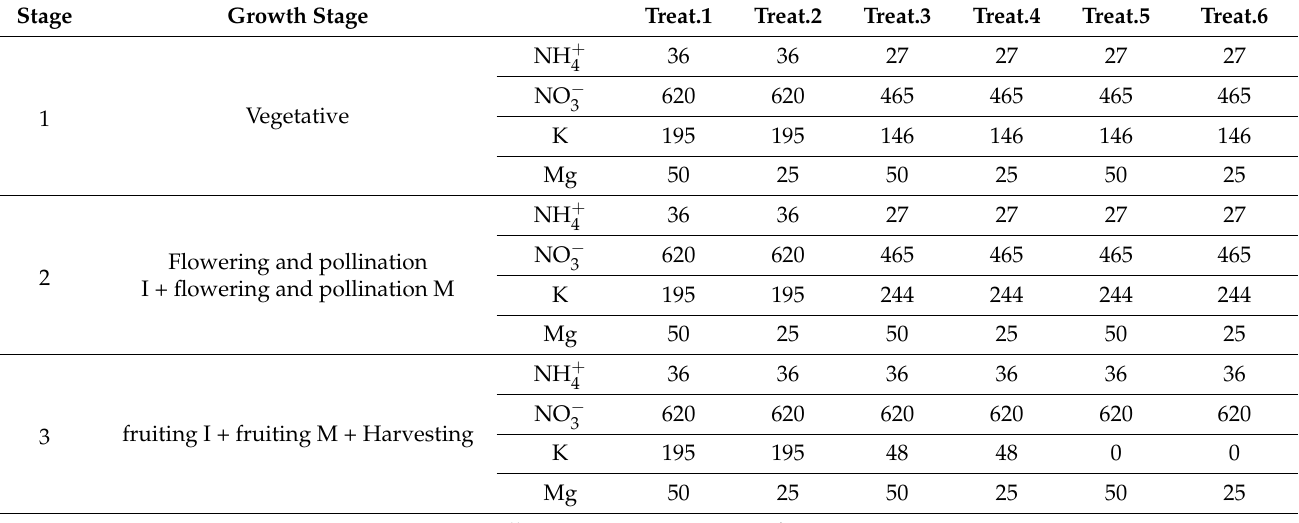
Table 1. Composition of NS solution used to replenish the water in the CHS among different growth stages.